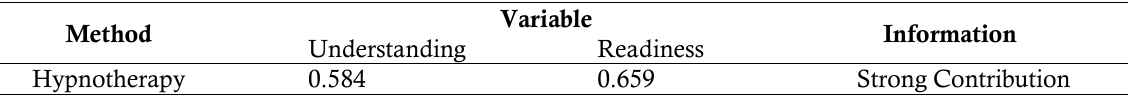
Table 1. Contribution of Hypnotherapy Method to Understanding and Readiness of Swimming